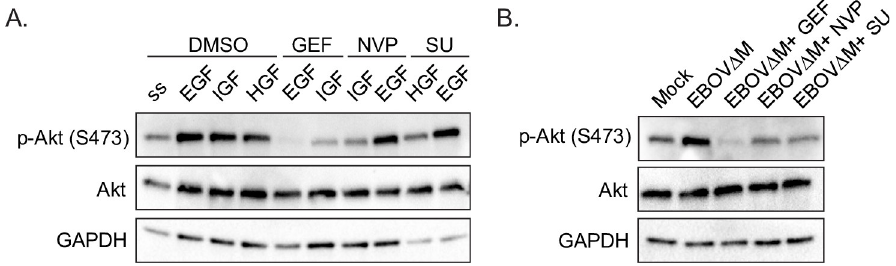
Fig 8. RTK inhibitors block EBOV VLP-induced Akt phosphorylation. Vero cells were pre-treated with Gefitinib (5 μ M), SU11274 (2.5 μ M), NVP-ADW742 (2.5 μ M) or vehicle (DMSO, 0.1%) in serum-free HBSS for 1h. Cells were